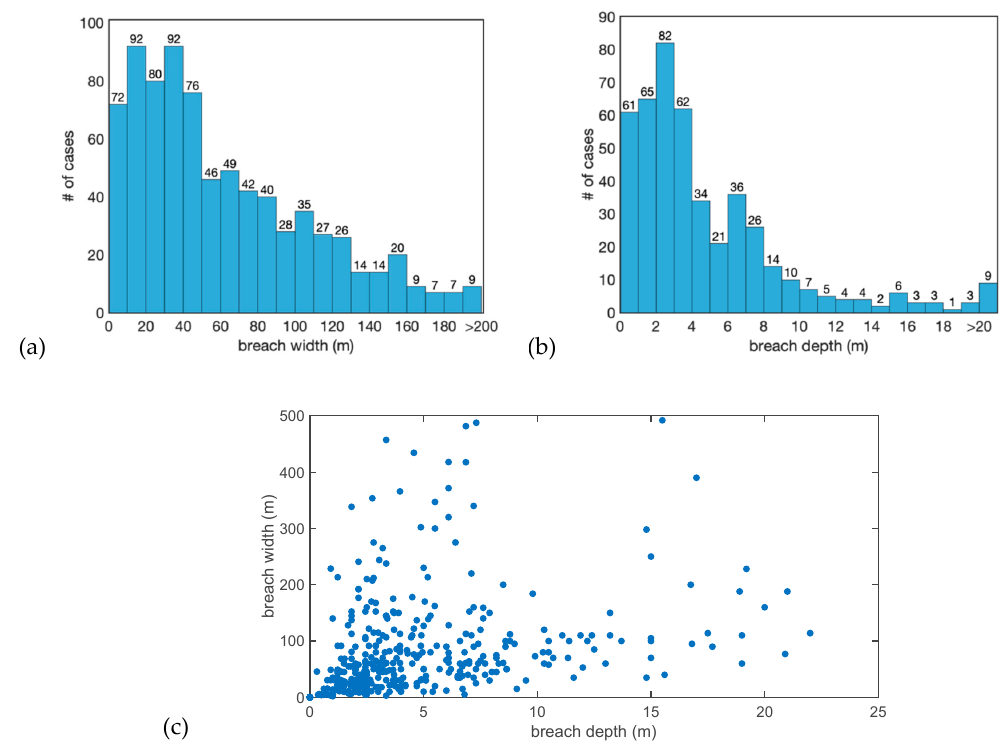
Figure 7. Statistics on ( a ) breach depth (450 cases), ( b ) breach width (785 cases) and ( c ) breach depth vs. width for (402 cases, Pearson coefficient, r = 0.164).